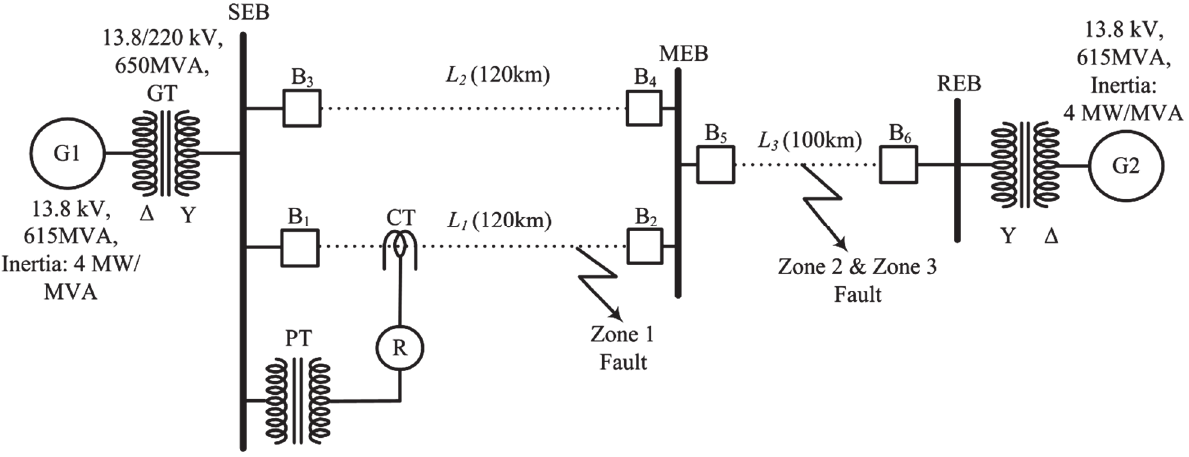
Fig. 1. Single line diagram of power